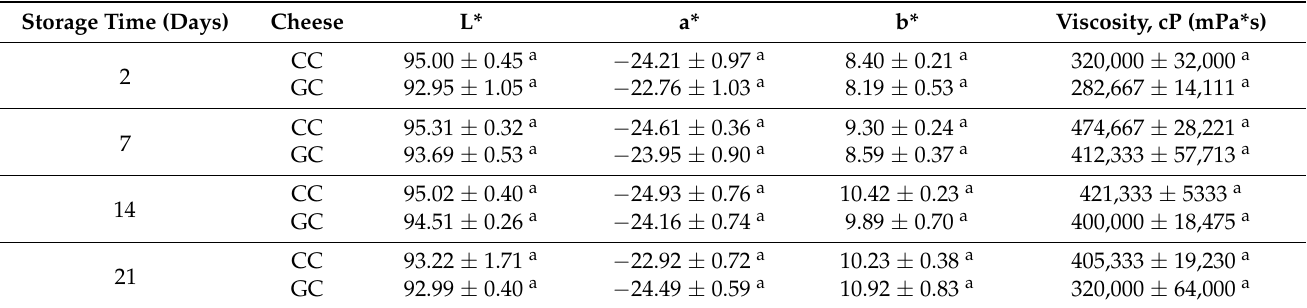
Table 2. Measurements of the color and viscosity of GC and CC fresh spreadable cheeses made from ovine